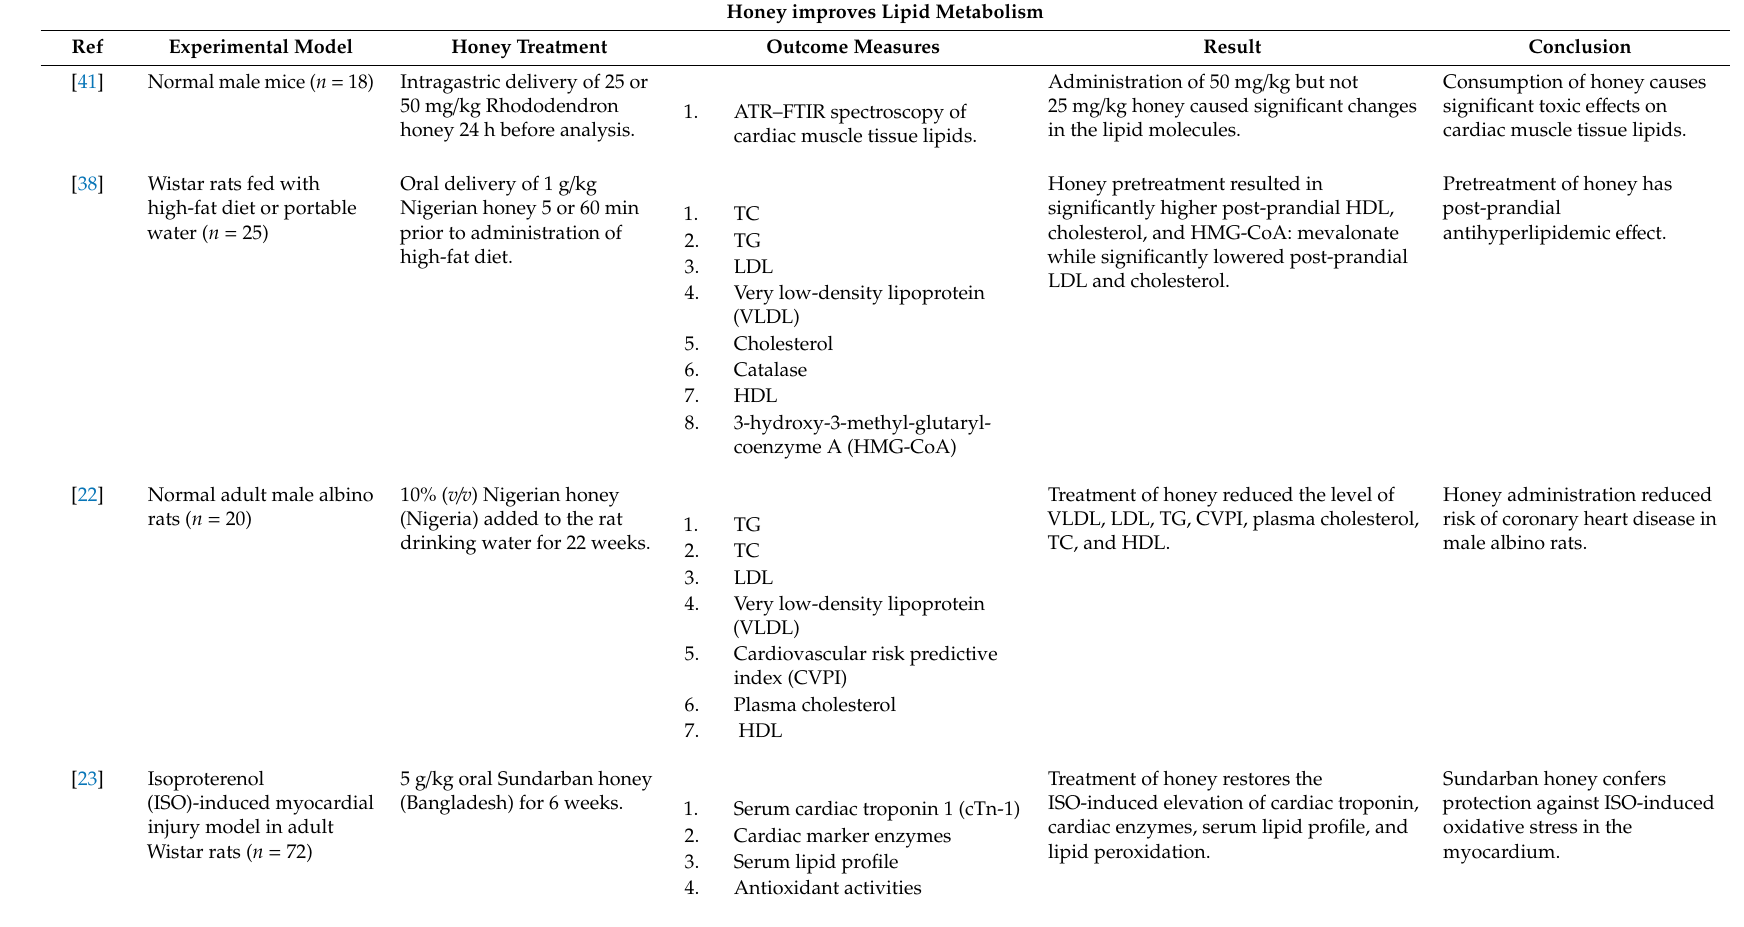
Table 1. Pre-clinical evidence on the cardioprotective e ff ect of